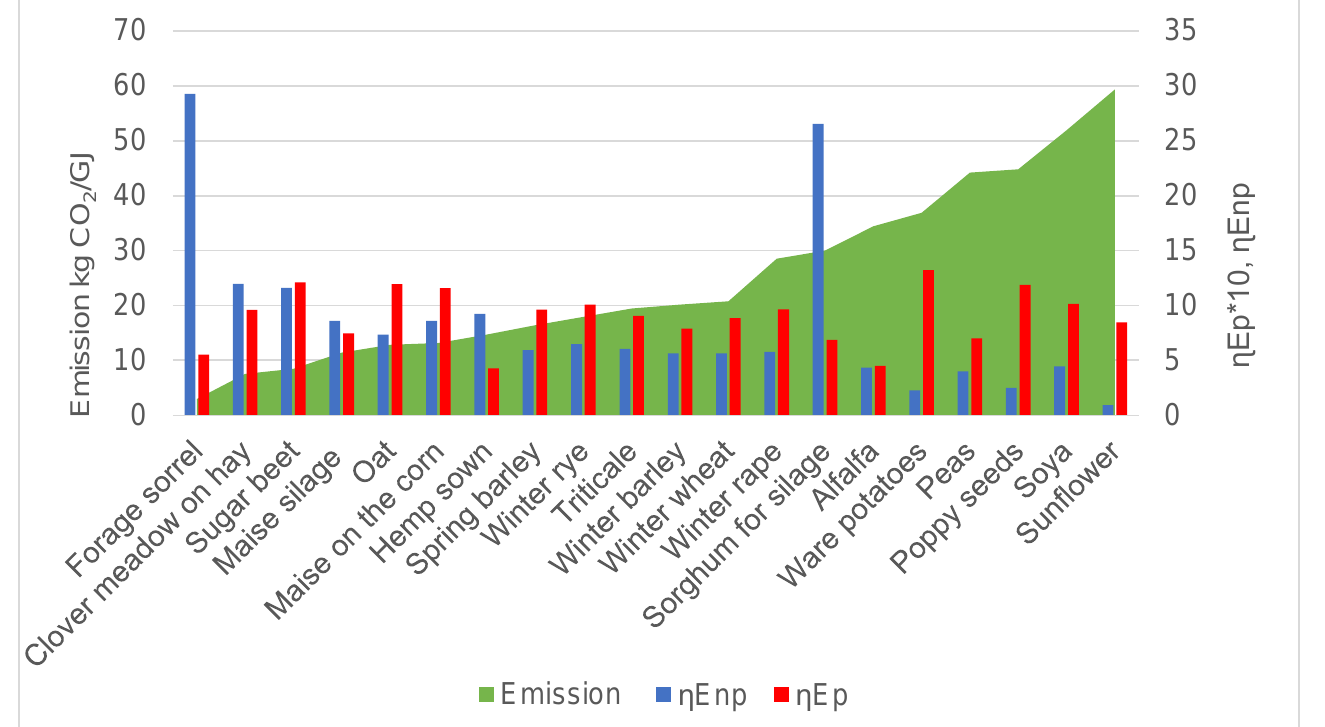
2 emission per GJ of energy in the